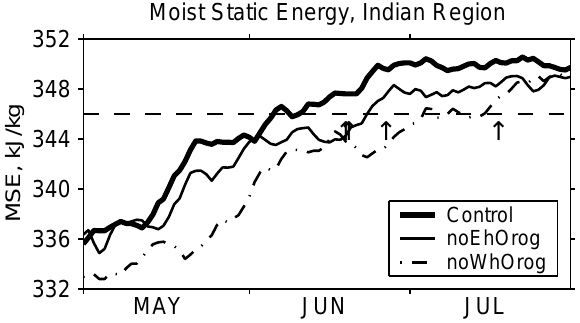
Fig. 11. Evolution of SMSE over the Indian region in the control , noWhOrog and noEhOrog